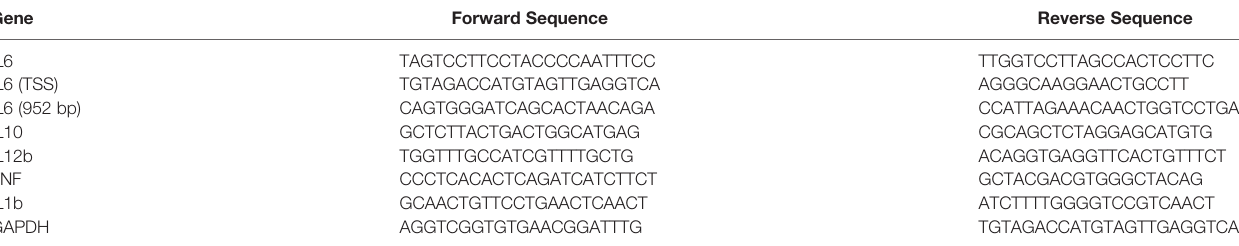
TABLE 1 | qPCR primer